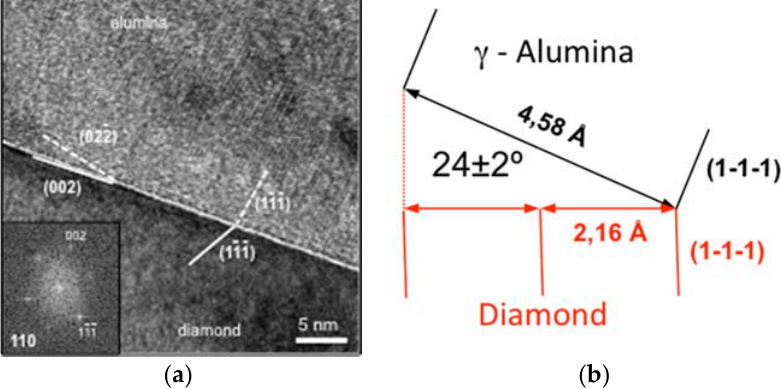
Figure 4. ( a ) HREM micrograph of sample C, where a fully crystalline alumina layer is observed. Lines and dashed lines were used to indicate where the (cid:4666)11(cid:3364)1(cid:3364)(cid:4667) planes are in both diamond and alumina crystals. The insets correspond to the FFTs of both materials; ( b ) Schematic representation of the (cid:4666)11(cid:3364)1(cid:3364)(cid:4667) planes’ correspondence at the diamond/alumina interface in sample C.